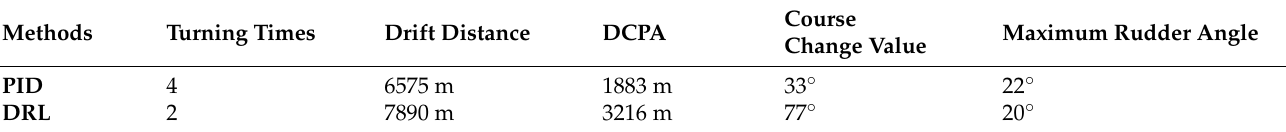
Figure 15. Simulation result for multi-ship collision avoidance based on PID (1: rudder angle; 2: course; 3: distance). Table 3. Comparisons between different